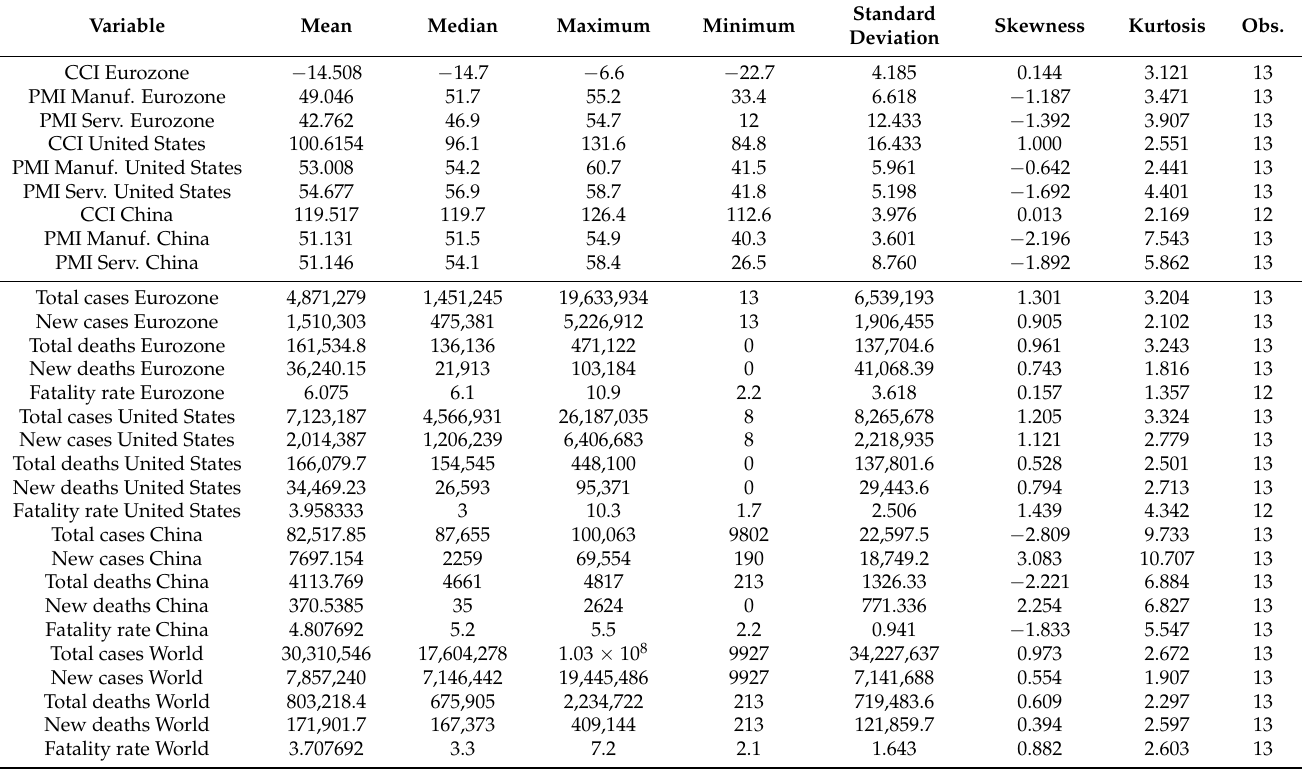
Table 2. The dynamics of COVID-19 related variables are shown in Appendices A–D. Table 2. Summary of descriptive statistics of models